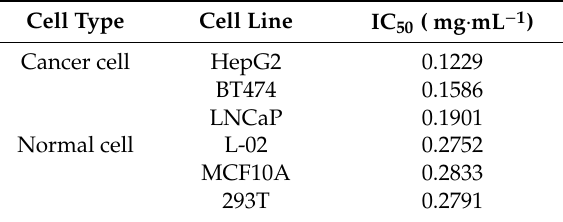
Table 1. The half maximal inhibitory concentration (IC 50 ) values of BPNS@cPA6 against cell lines (mg · mL − 1